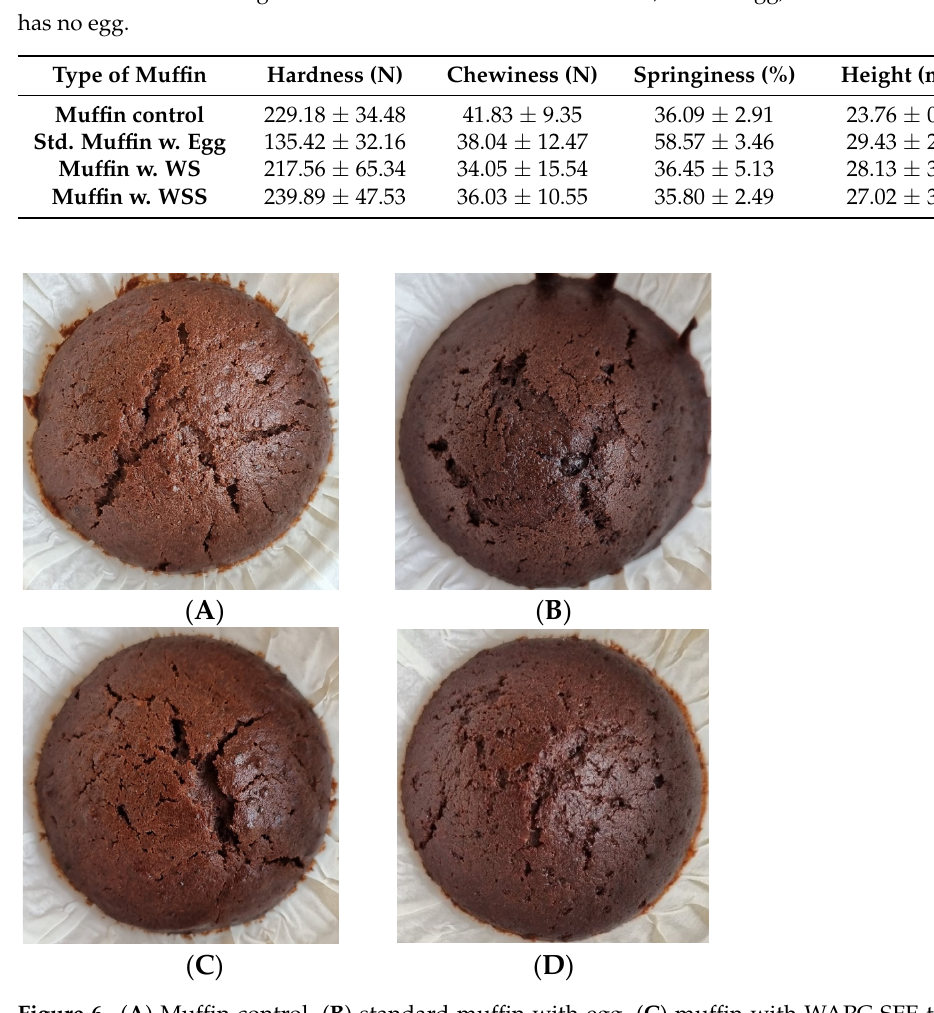
Figure 6. ( A ) Muffin control, ( B ) standard muffin with egg, ( C ) muffin with WAPC SFE treated, Figure 6. (A) Muffin control, (B) standard muffin with egg, ( C ) muffin with WAPC SFE treated, ( D ) muffin with WAPC not SFE treated. ( D ) muffin with WAPC not SFE treated.